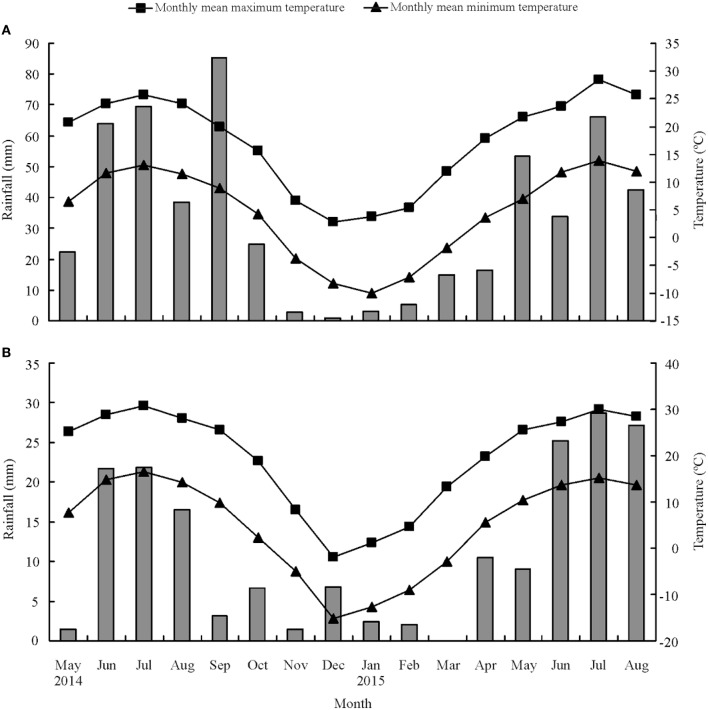
Mean monthly maximum and minimum temperatures (°C) and total monthly rainfall (mm) at Yuzhong (A) and Linze (B), respectively.